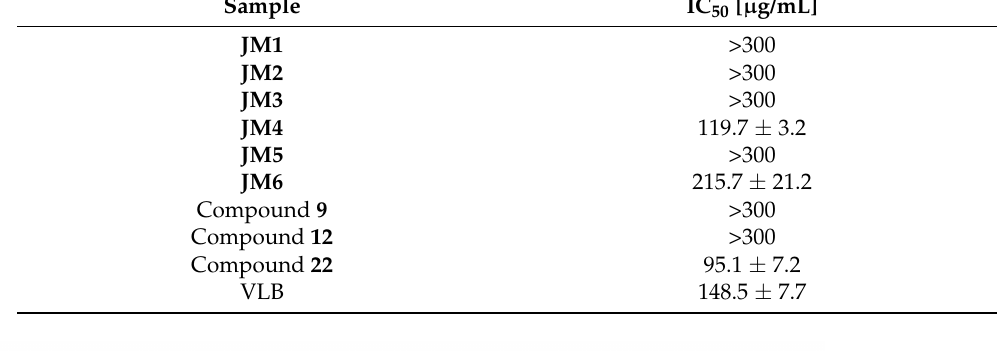
Table 2. IC 50 of viability of CRL-1585 human amelanotic melanoma cells treated for 24 h with different concentrations of JM1 – JM6 and isolated compounds 9 , 12 , 22 from J. montana . Mean values ± SD from three independent experiments done in duplicate are presented. (IC Sample